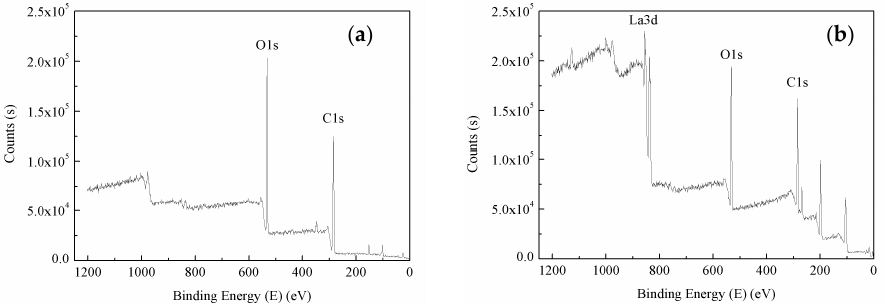
Figure 8. Wide-scan photoelectron spectra of BF: ( a ) untreated; ( b ) RES-treated.